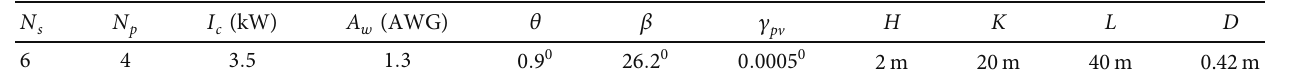
Table 8: The most optimal design.